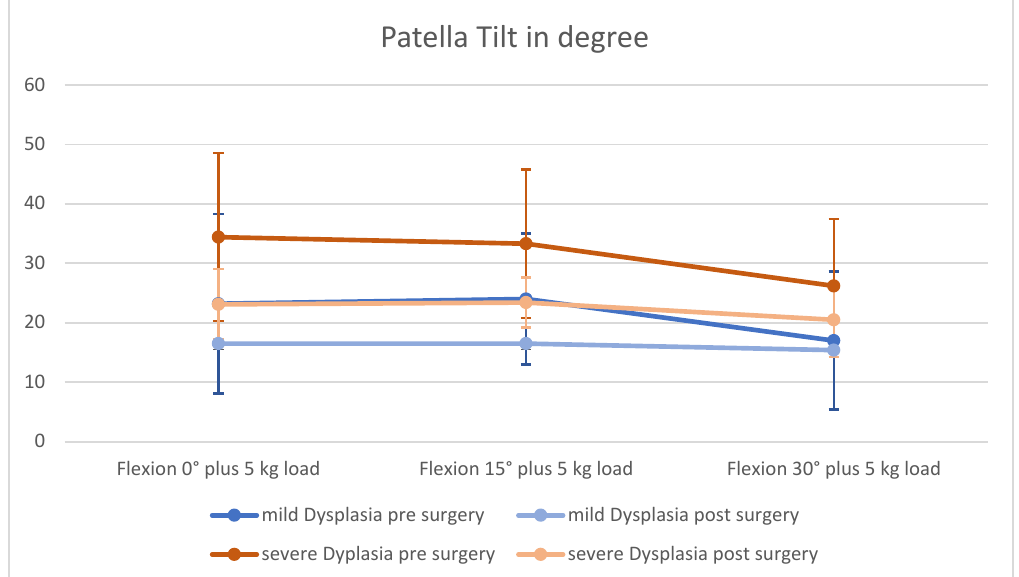
Figure 4. Patella tilt with loading before and after surgery. Table 2. Patella tilt in degree.